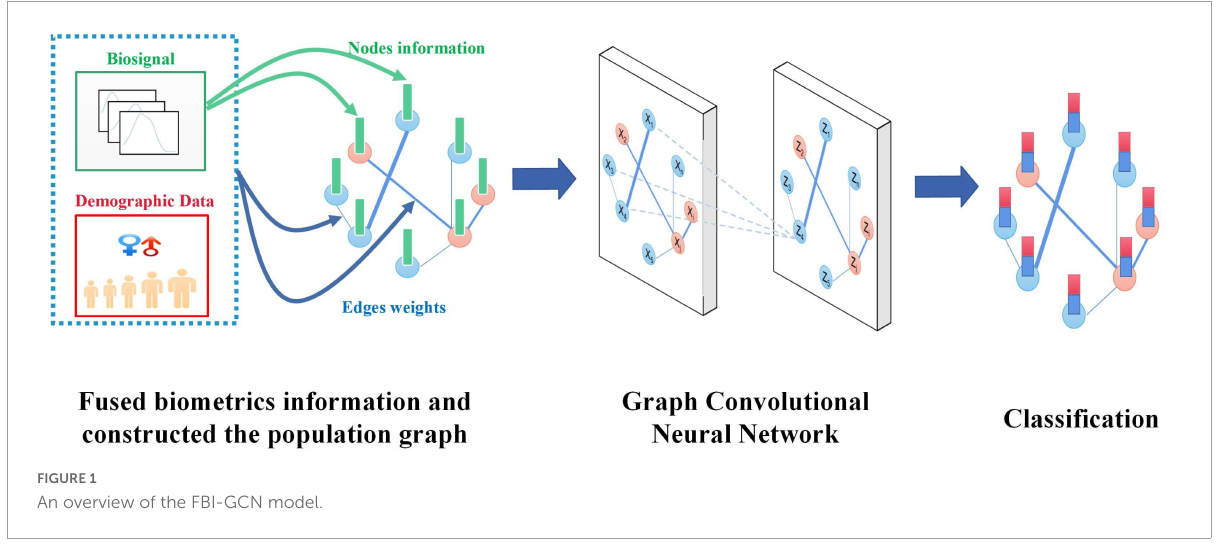
FIGURE1 An overview of the FBI-GCN